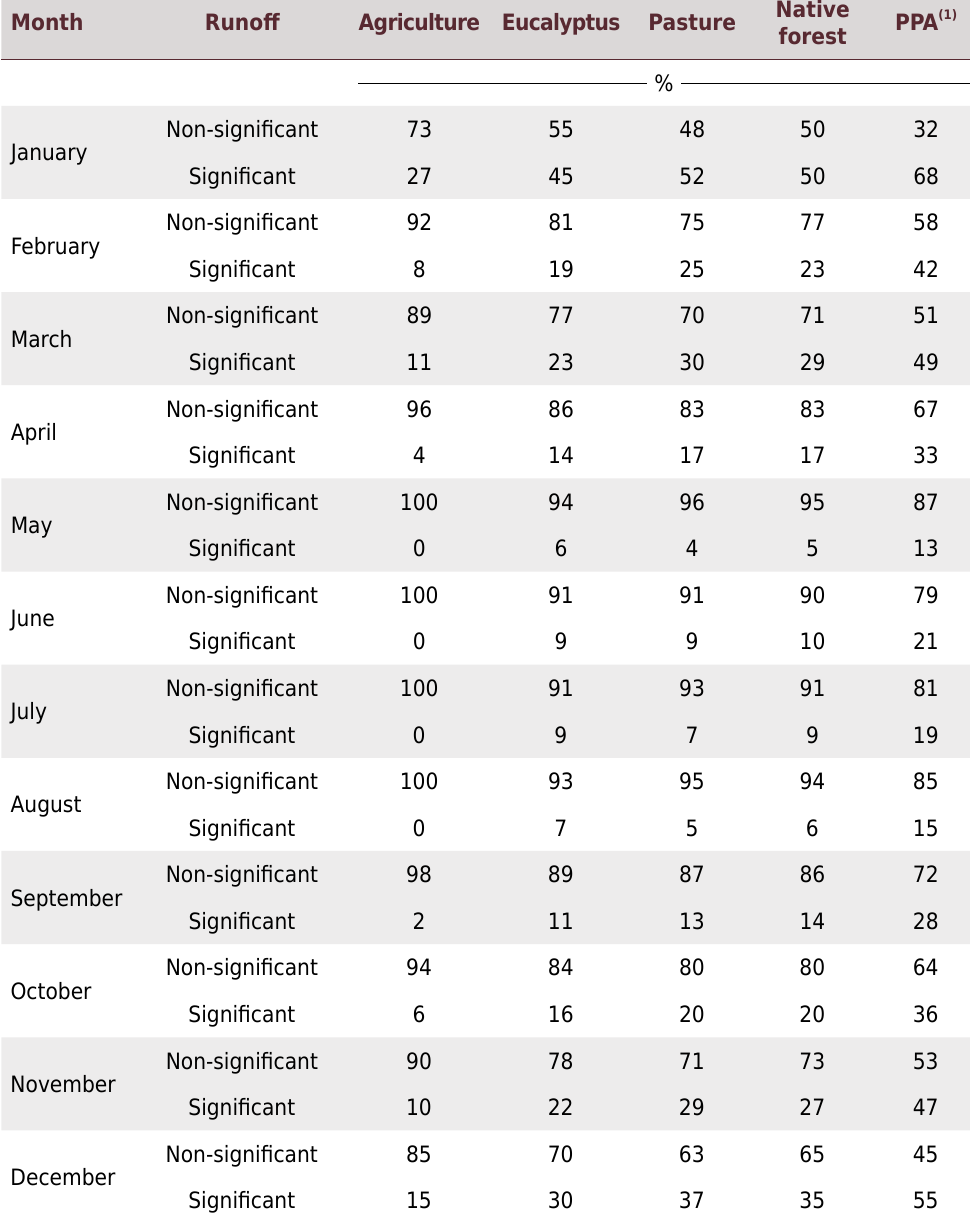
Table 1. Percentage of vulnerable area to runoff according to the current land use in the Posses watershed Month Runoff Agriculture Eucalyptus